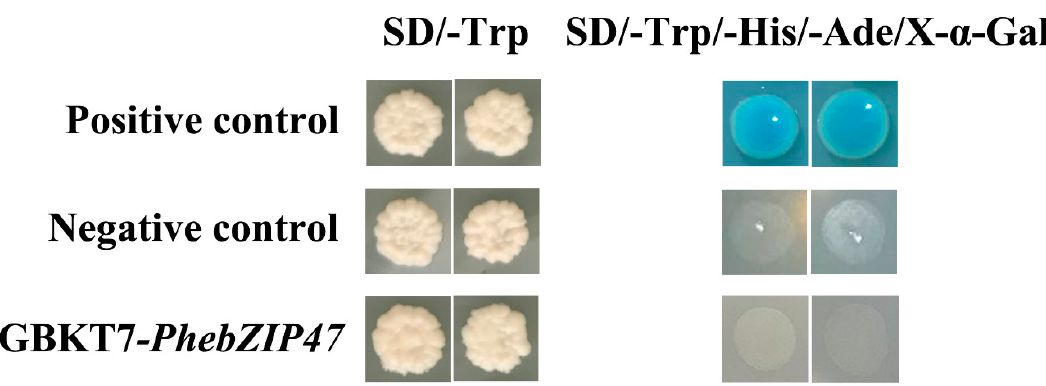
Figure 11. Subcellular localization of PhebZIP47 and PhebZIP126. The two PhebZIP-GFP fusion proteins ( PhebZIP47 -GFP, PhebZIP126 -GFP) and GFP as a control were transiently expressed in N. tabacum leaves and observed under a fluorescence microscope.